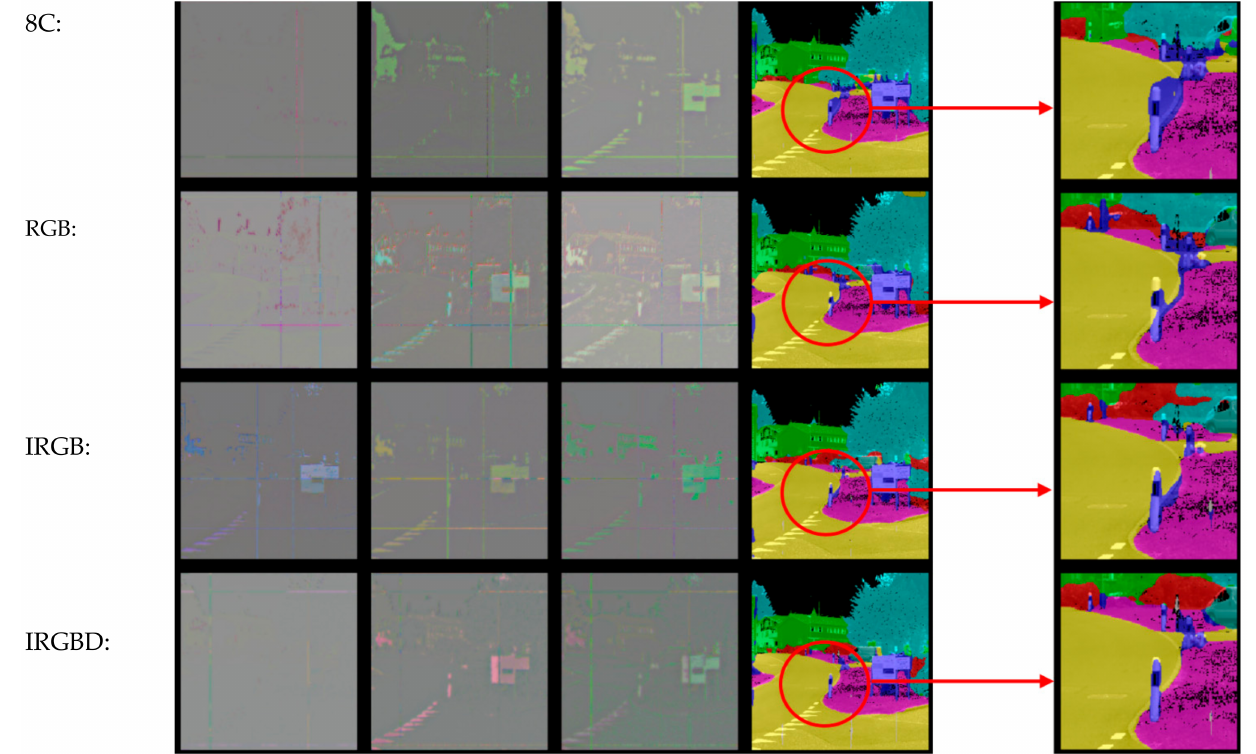
Figure 7. Feature maps and segmentation results for four combinations in the street view